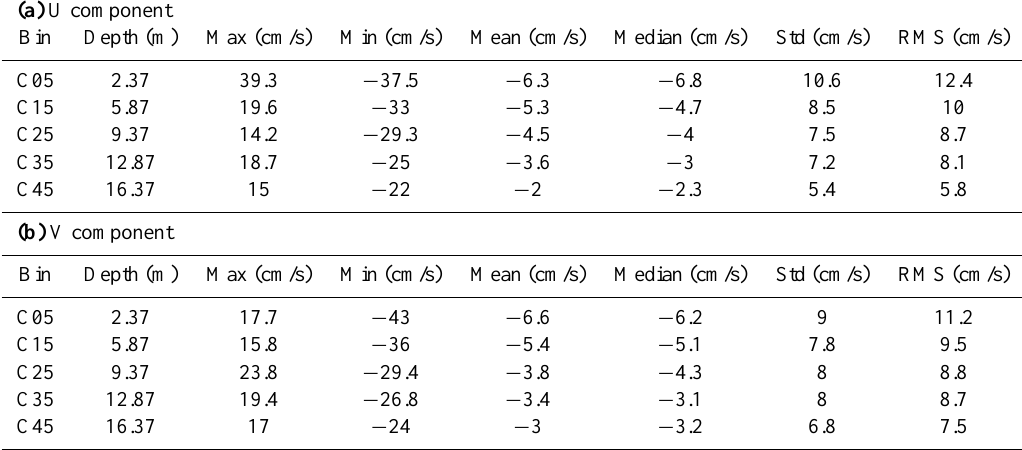
Table 1. Basic statistical properties (maxima and minima, mean and median, standard deviation and root-mean-squares) of subsurface currents for the period September to October 2002. Table 1a refers to the U component, while Table 1b contain statistics for the V component. Units are